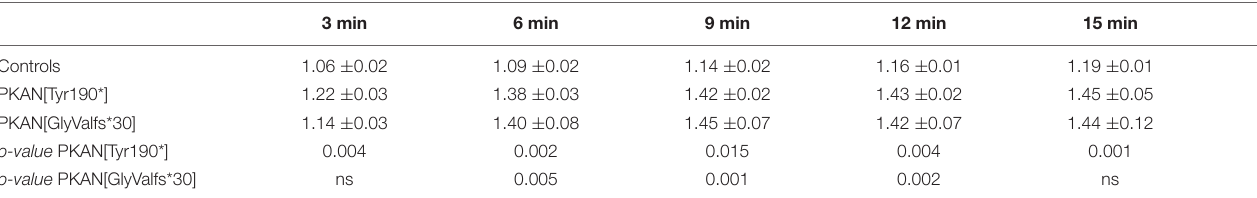
FIGURE 2 | the recycling compartment (scale bar 10 µ m). (C) Histograms show the mean vesicular Synbond uptake in astrocytes from controls and PKAN ( t -test). (D) Plots are the percentages of active endosomes, identified as described in methods and results, at different time points (5 min and 15 min) [ (C,D) n ≥ 7,382 vesicles analyzed for each, from at least three independent replicates each]. (E) Binding dynamics from controls and PKAN astrocytes (Mann–Whitney test, n = 5 ROIs from n 5 cells analyzed for each, from at least three independent replicates each). (F) Schematic representation of the double pulse experiment to tag vesicles active during different epochs. (G) Confocal image of an exemplar astrocyte expressing SynaptoZip (green) and its Synbond vesicular uptake (red and blue) as in the protocol depicted in panel (F) . Middle and right panels are the regions indicated by the white square in the left panel. Synbond positive single endosomes are visible, some are enriched by both 647 and 568 Synbond peptides (white arrows) and others are positive for Synbond-647 but the fluorescence from Synbond-568 is faint (yellow arrow, scale bar 6 µ m). (H) Bars are the mean vesicular percentages of Synbond fluorescence during the second epoch calculated on first epoch Synbond fluorescence, from the same vesicles, normalized on controls (one-way ANOVA). Curves in panel (I) are cumulative probabilities distributions of Synbond uptake in the two sequential epochs (15 min each), from controls and PKAN astrocytes, showing impairment in PKAN astrocytes uptake probabilities compared to controls [ (H,I) n at least 800 vesicles analyzed for each, from n = 3 independent replicates]. Error bars are SEM for all. * p < 0.05; ** p < 0.01; *** p < 0.001; **** p < 0.0001 for all. TABLE 2 | SB live binding dynamics.